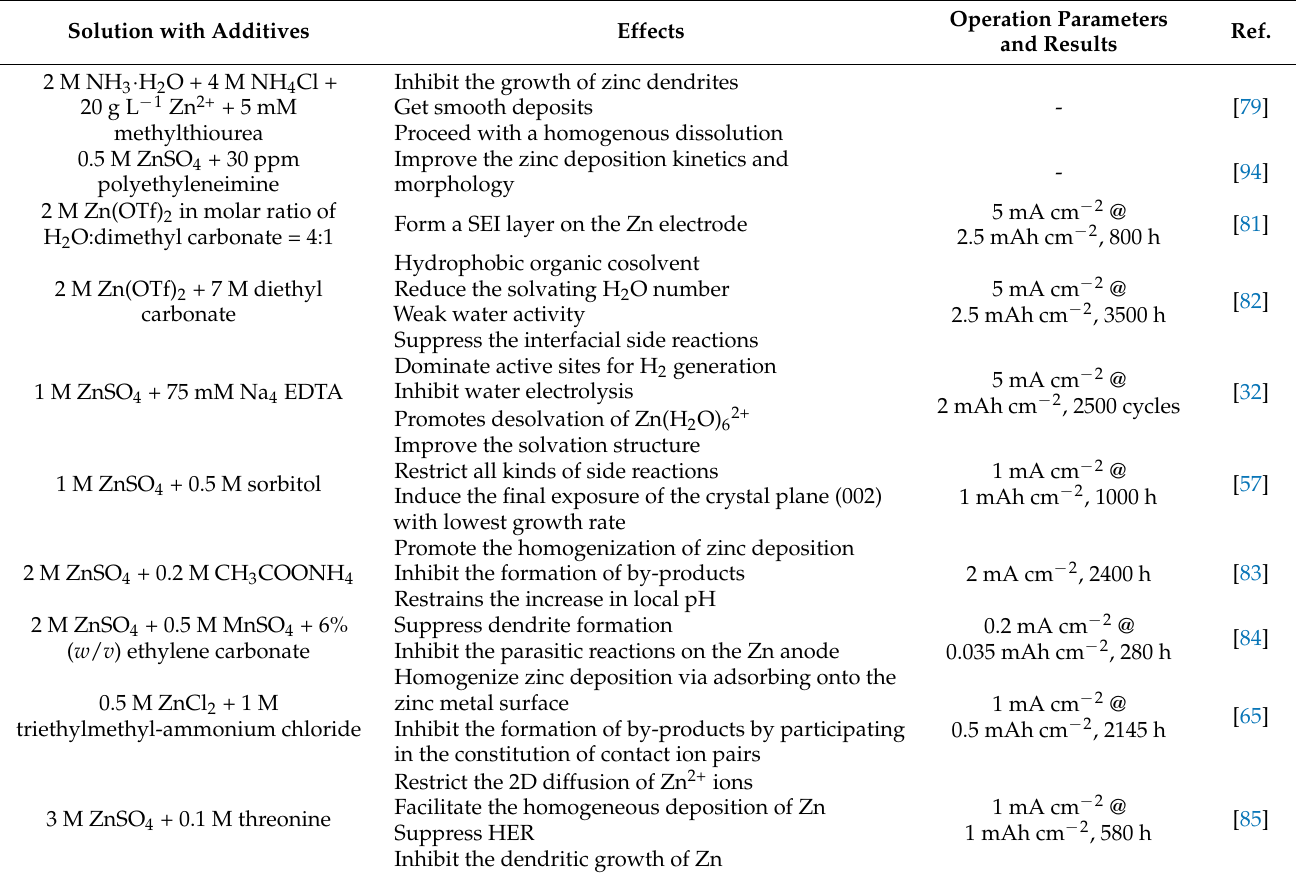
Table 2. Organic additives and effects in